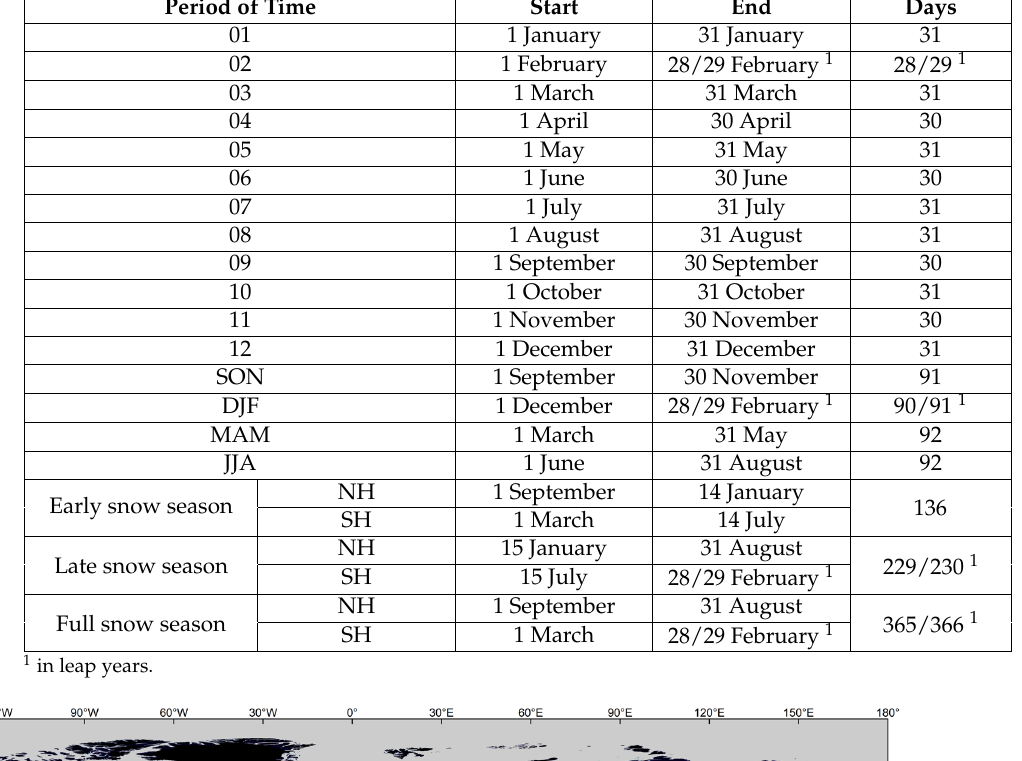
Table 1. Selected periods in this study. In addition to the months, there are meteorological seasons and snow seasons (based on hydrological years).